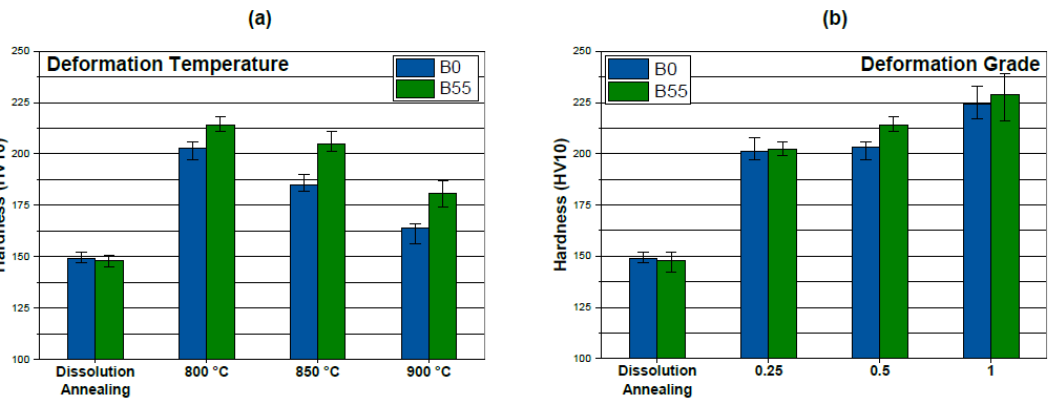
Figure 8. HV10 hardness results of the thermomechanically treated alloys B0 and B55 in comparison to the precipitate-free microstructure after solution annealing in dependence on ( a ) deformation temperature with a 0.5 deformation grade and ( b ) a deformation grade at an 800 °C deformation